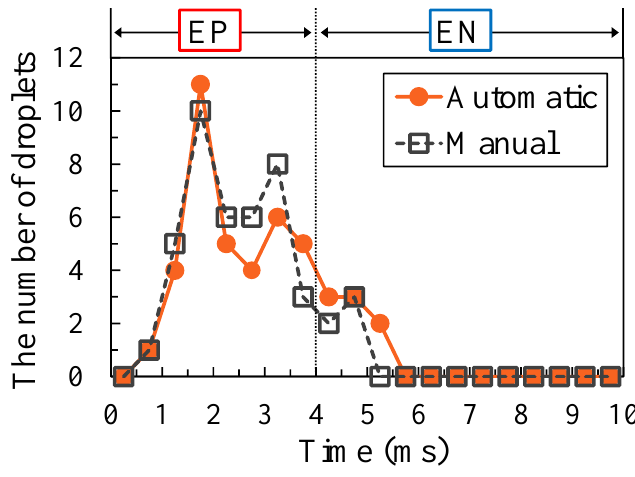
Figure 3. A comparison between the automatic and manual measurements.